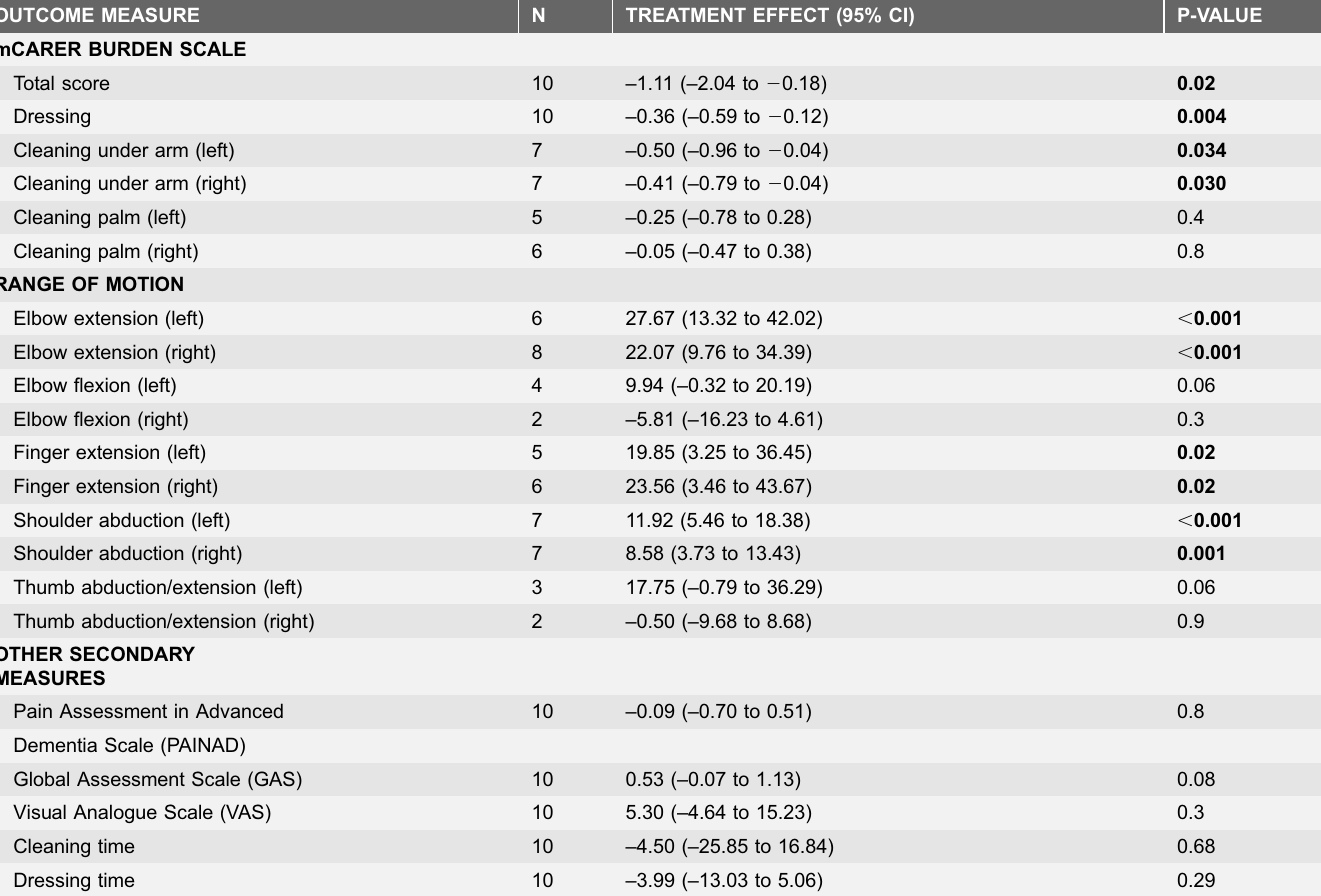
Table 4. Mixed model outcomes of mCBS, PROM, PAINAD, GAS, VAS and time to perform care at 2 and 6 weeks after treatment with Incobotulinumtoxin